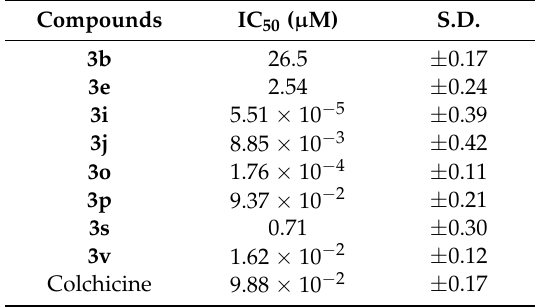
Table 4. IC 50 values of 3b , 3e , 3i , 3j , 3o , 3p , 3s , and 3v against tubulin using colchicine as a positive